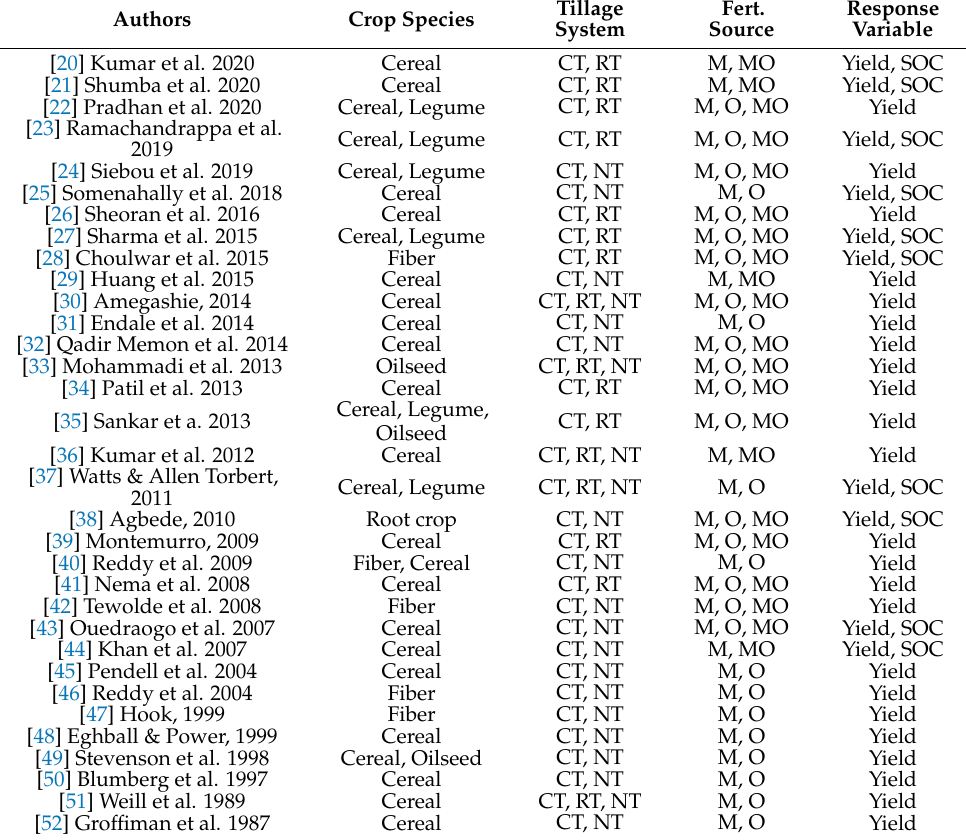
Table 1. Detailed information of the studies included in the meta-analysis. Studies are reported in temporal